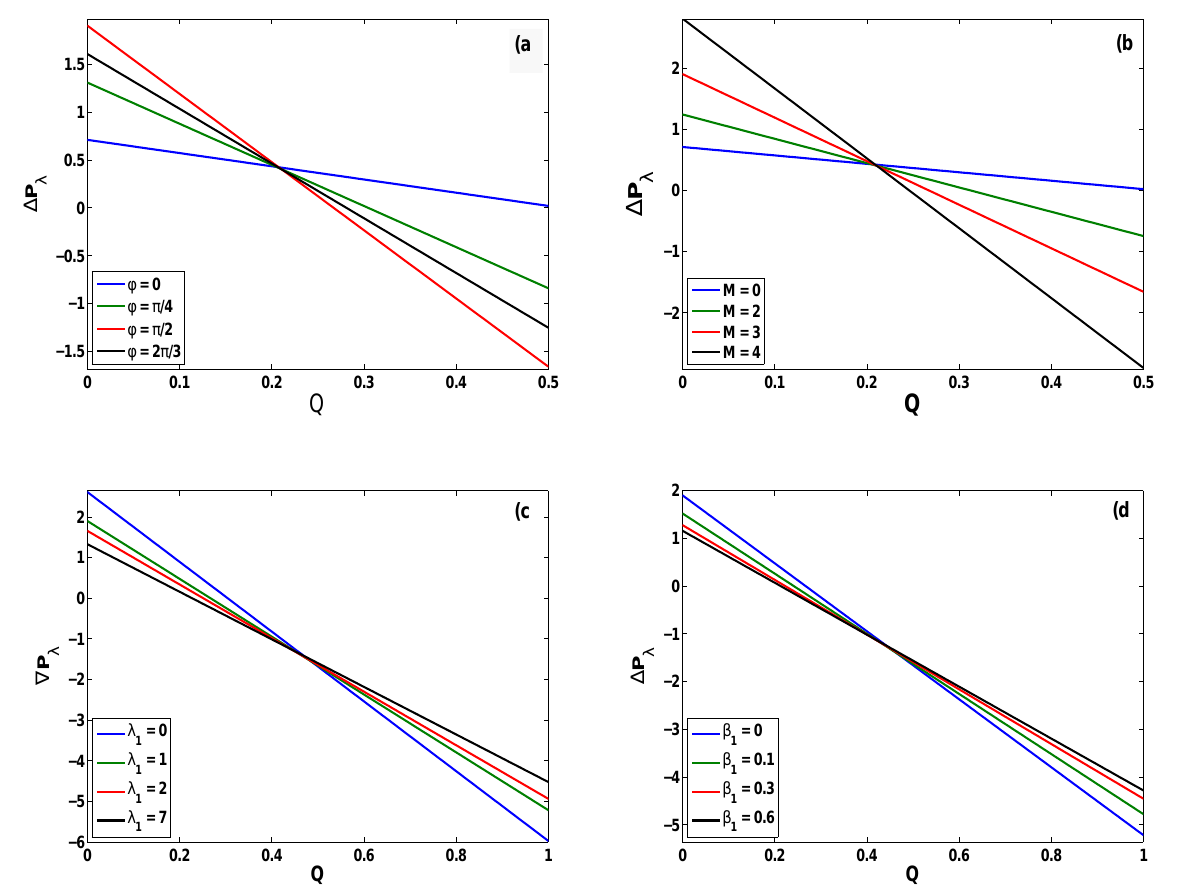
Figure 2. Pressure drop ∆ P λ vs Q for ( a ) : M = 4, λ 1 = 1, β 1 = 0.2, ( b ) : ϕ = π /4, β 1 = 0.2, λ 1 = 1, ( c ) : ϕ = π /4, β 1 = 0.2, M = 1, ( d ) : M = 4, λ 1 = 1, ϕ = π /4.